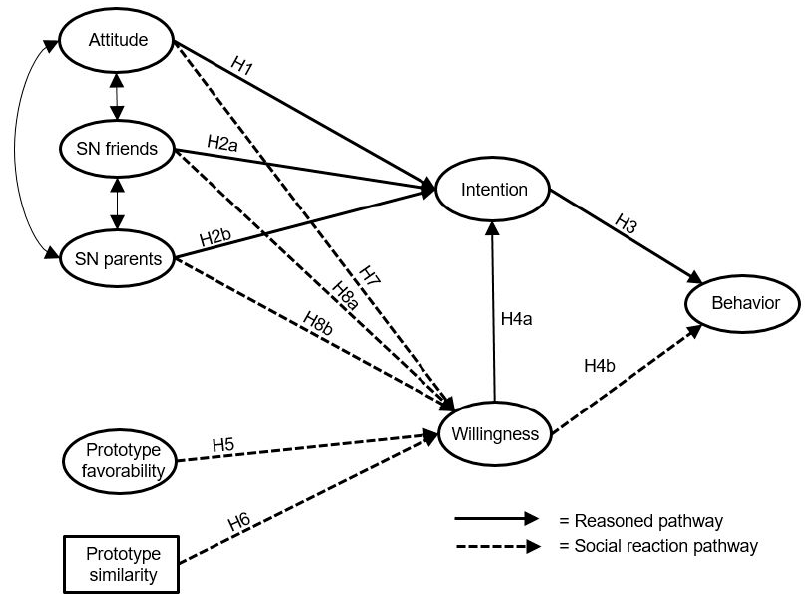
Figure 1. Conceptual model.